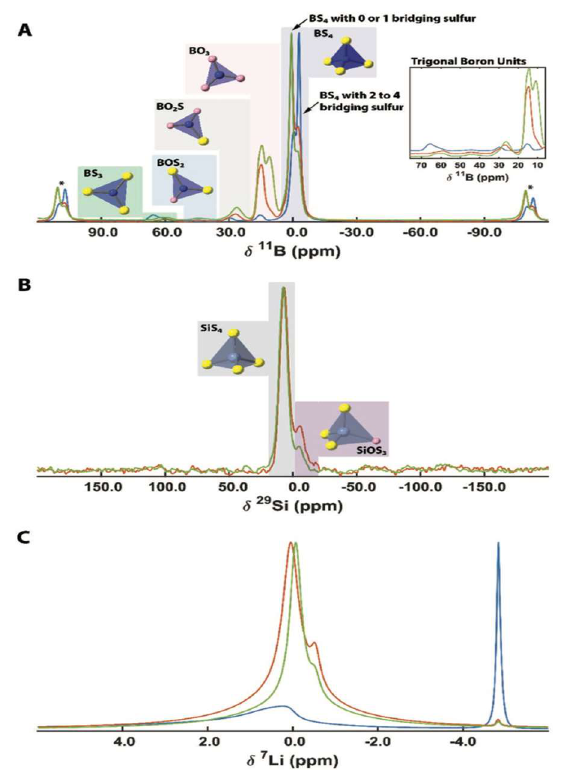
Figure 3. ( A ) 11 B, ( B ) 29 Si, and ( C ) 7 Li magic angle spinning (MAS) spectra of LIBOSS for x = 0 (blue), x = 0.25 (orange), and x = 0.5 (green) [11] .